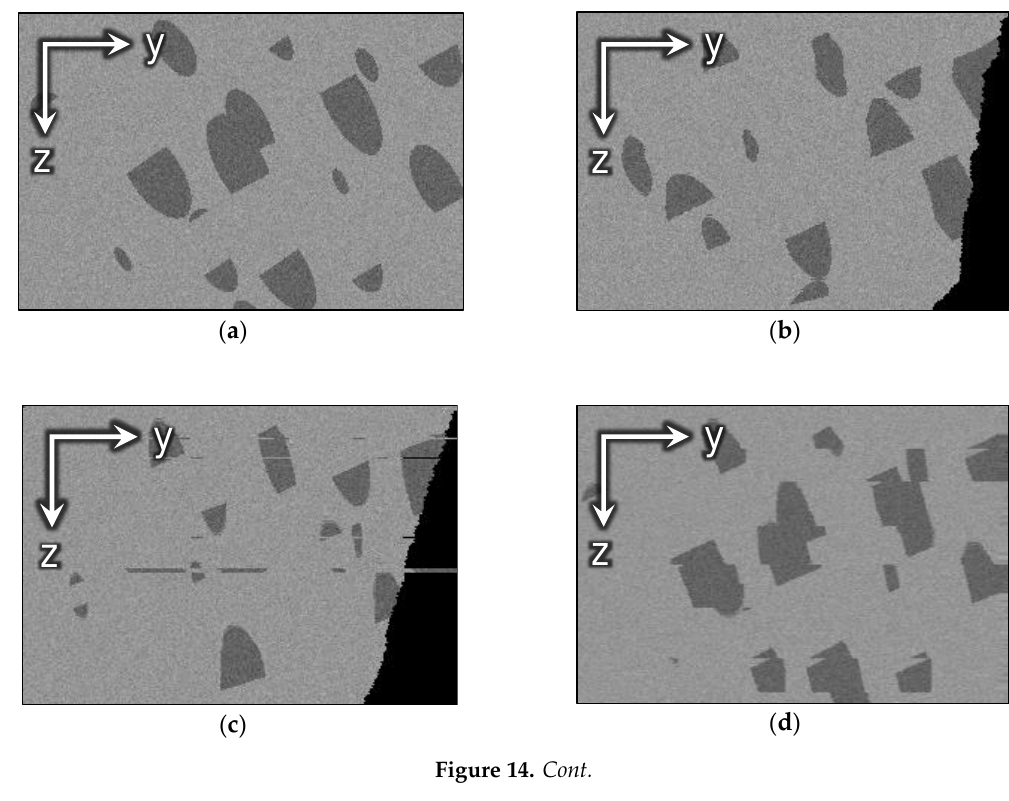
Figure 13. The displacements found by the proposed algorithm for the synthetic sample: ( a ) in the X axis; ( b ) in the Y axis.